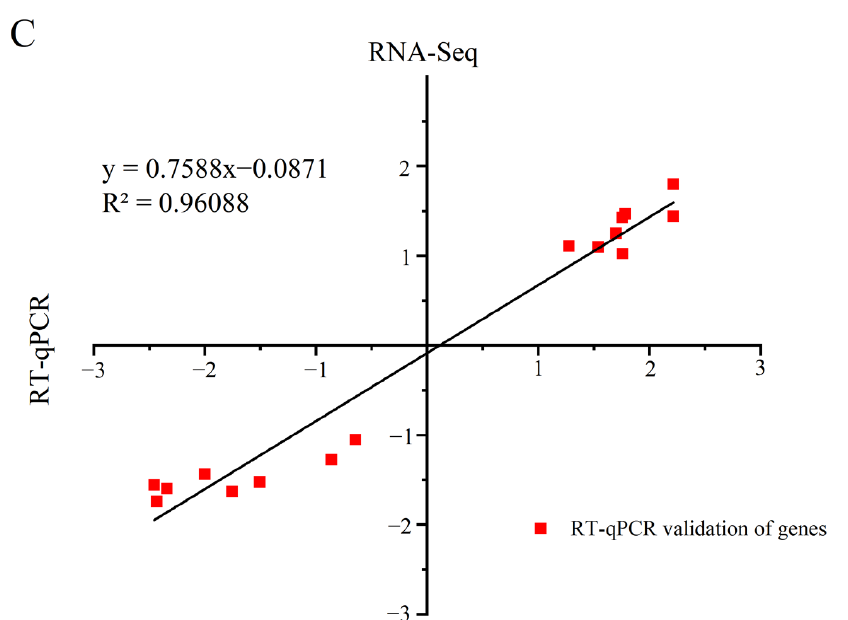
Figure 4. Validation of DEGs and clustering heatmap. ( A ) Validation of differential expression by RT-qPCR. Error bars indicate SEM ( n = 3). ( B ) Cluster map of gene expression patterns demonstrating general patterns in distinct liver samples. ( C ) Correlation analysis of log2-fold change values between RNA-Seq data ( x -axis) and RT-qPCR data ( y -axis).